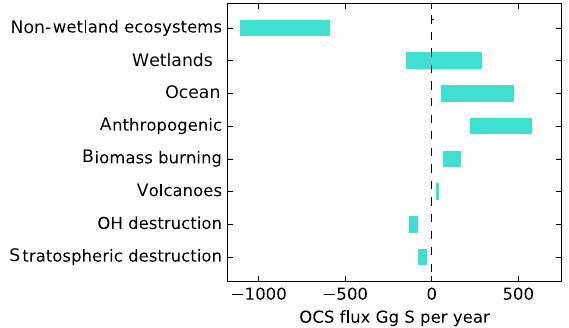
Figure 1. A bottom-up budget of atmospheric OCS on the global scale. Positive values indicate a source to the atmosphere. No at- tempt has been made to preserve mass balance. The contribution of lakes and non-vascular plants is included in the non-wetland ecosys- tem estimate. The small increase of OCS in the atmosphere is not included in this